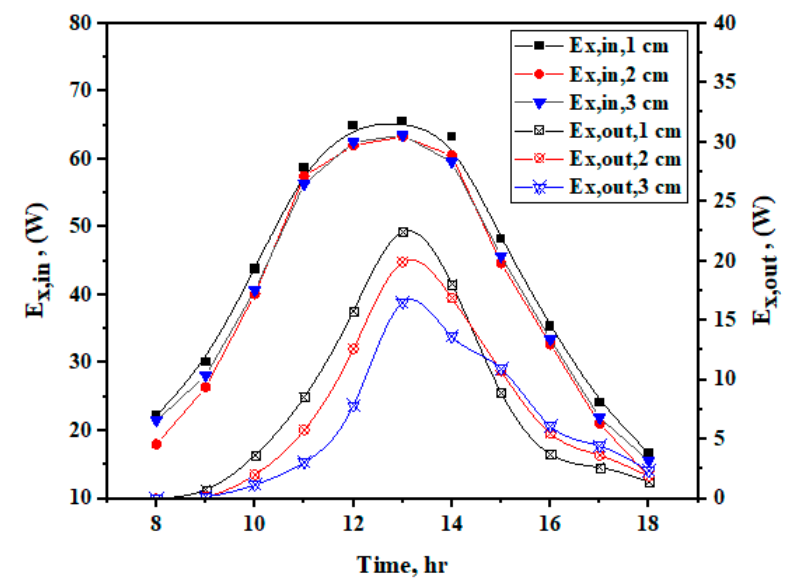
Figure 10. Hourly input and output exergy rates with respect to time.